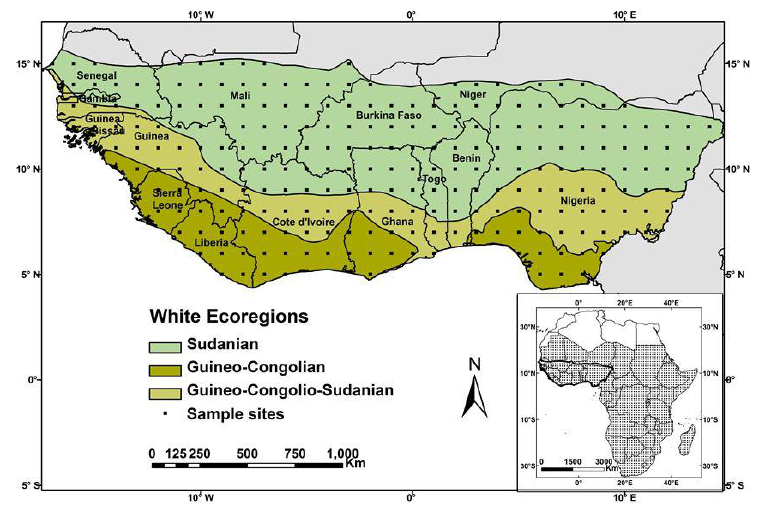
Figure 1. Study area and sampling scheme covering three ecoregions in West